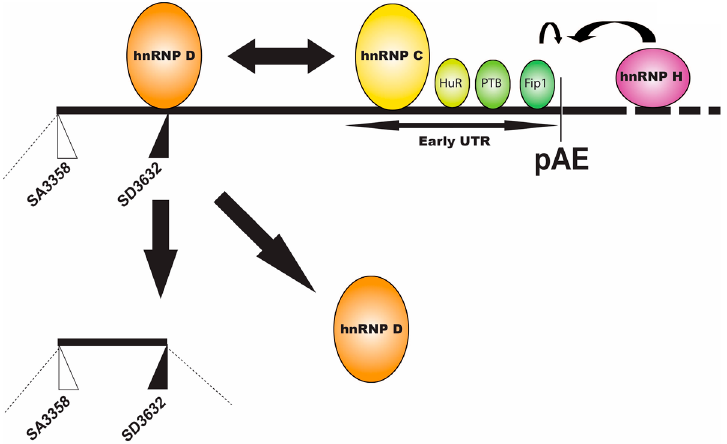
Figure 6. Schematic drawing of the middle region of the HPV16 genome. HPV16 3 ′ -splice site SA3358, used by both early and late mRNAs is indicated. The exclusively late 5 ′ -splice site SD3632 with hnRNP D binding to upstream splicing silencer elements to suppress SD3632 [41]. heterogenous nuclear ribonuclear protein C (hnRNP C), HuR, polypyrimidine tract binding protein (PTB) and Fip1 binding to the HPV16 early untranslated region (UTR) are indicated [6,9,22,43,48,51]. hnRNP H binds to sequences downstream of the HPV16 early polyadenylation signal pAE to promote polyadenylation at pAE [6,9,46,47]. Double arrow represents the interactions between hnRNP C that binds to the HPV16 early UTR, and hnRNP D that binds to the splicing silencers upstream of SD3632 [9,48]. The interaction of hnRNP C with hnRNP D activates HPV16 late 5 ′ -splice site SD3632 and induces splicing from SD3632 to SA5639 and thereby activates production of the spliced, major late L1 mRNAs